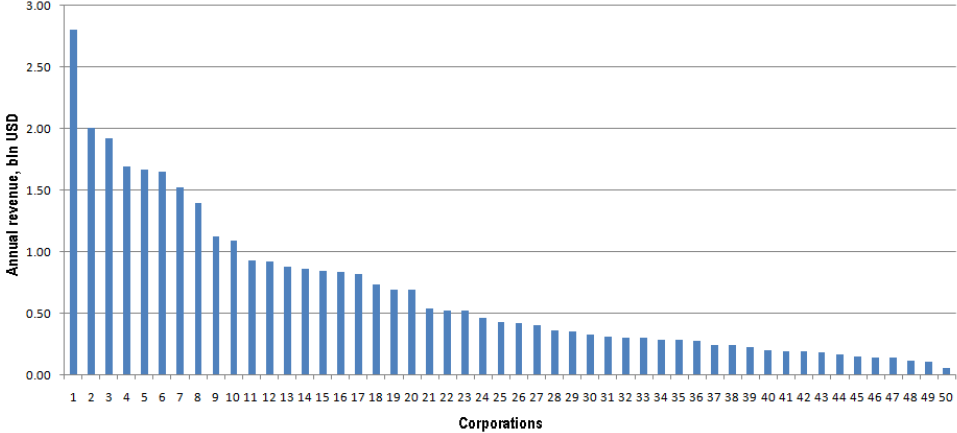
Figure 2. Distribution of the considered Russian agricultural corporations depending on their annual revenue (based on information from [23]).